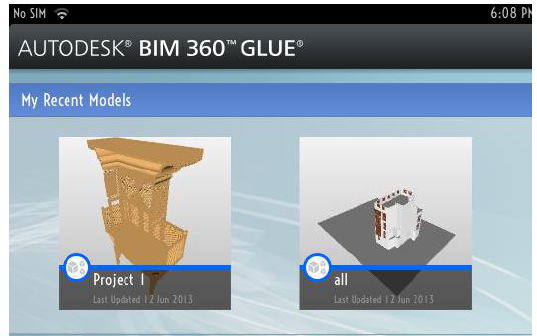
Figure 6. Autodesk BIM 360 Glue.